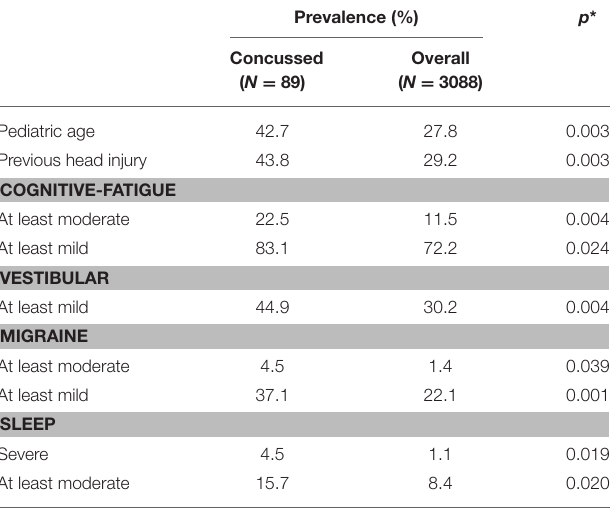
TABLE 2 | Baseline characteristics of those who became concussed during the study period compared against those of the entire sample.